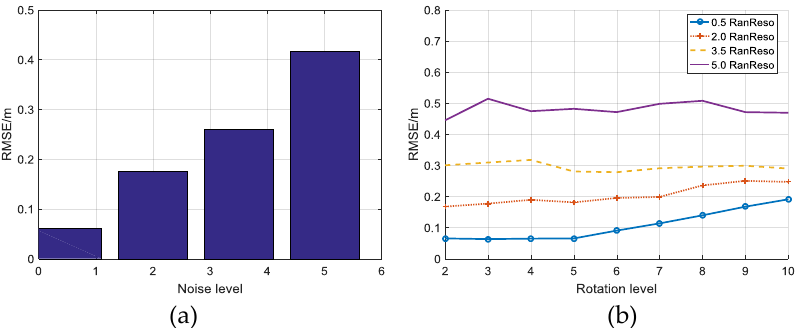
Figure 15. Variation of RMSE of multi-perspective 3D reconstruction with the noise level and rotation velocity level. (a) Variation of RMSE with respect to noise level when rotation velocity is 2 degrees per second. (b) Variation of RMSE with respect to rotation velocity level per noise level.